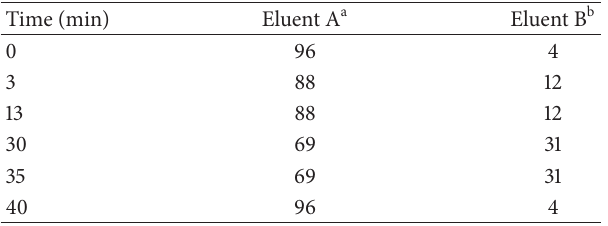
Table 1: Chromatographic gradient conditions for the analysis of GCA, BCA, and free amino